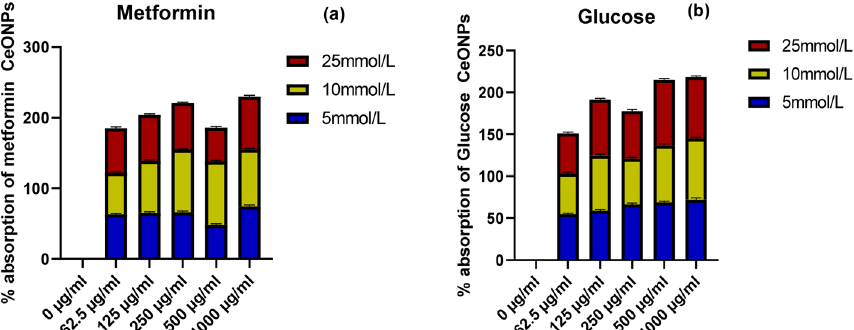
Figure 5. ( a ) explains the standard metformin effects on glucose absorption. The graph ( b ) explain the graphical percentage of CeONPs with three different concentrations 5, 10, and 25 mmol/L and The level of significance was p < 0.05 for the alpha-amylase assay. p-value lesser than 0.05 was considered significant along with the post hoc